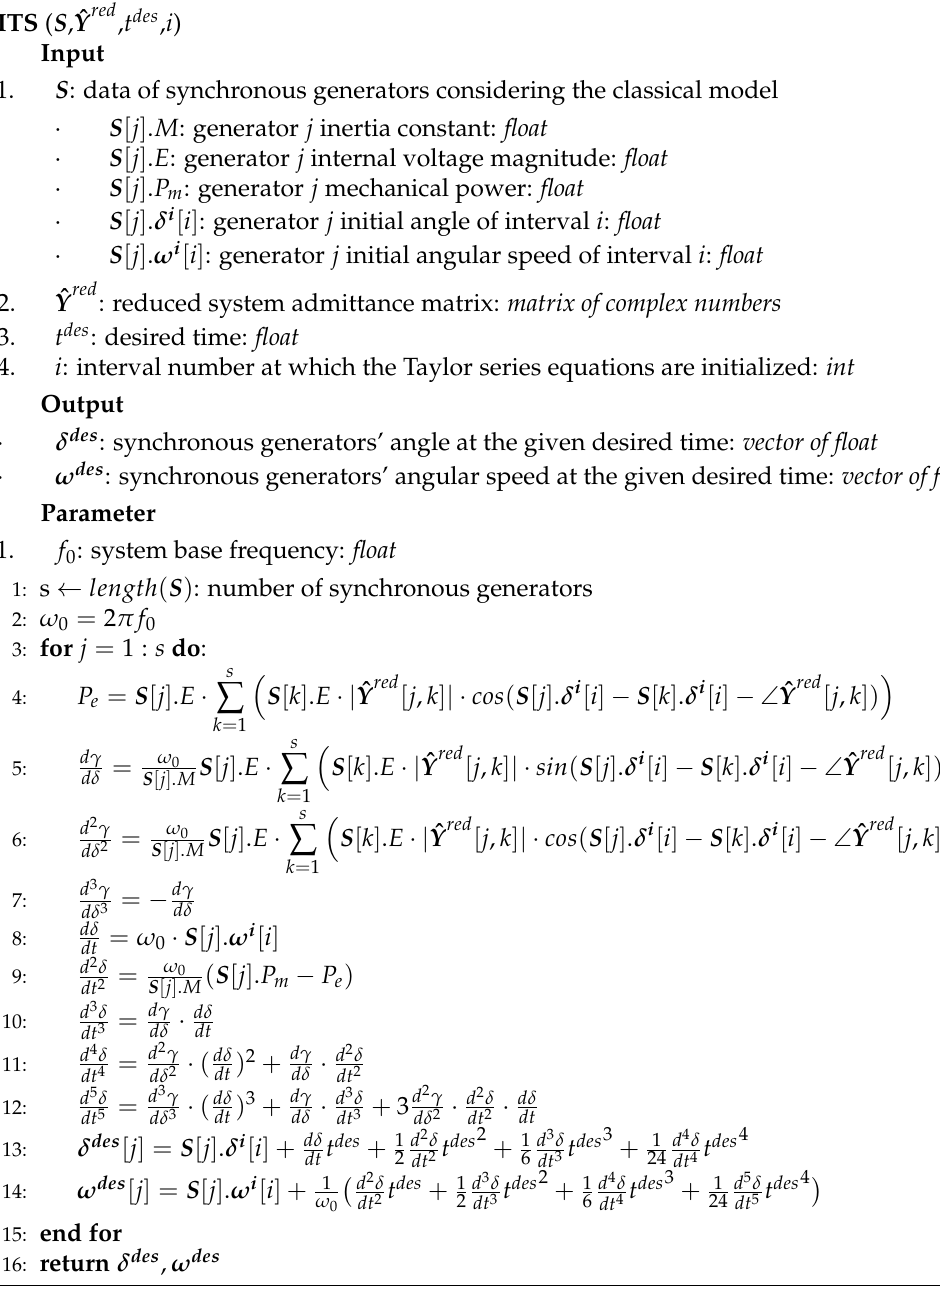
Algorithm A11 Individual Taylor series to find generators’ angle and angular speed at a desired time, starting from an initial angle and angular speed